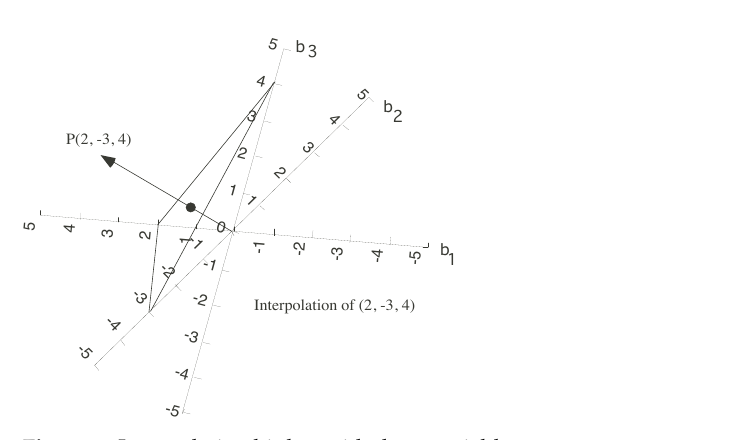
Figure 2. Interpolation biplot with three